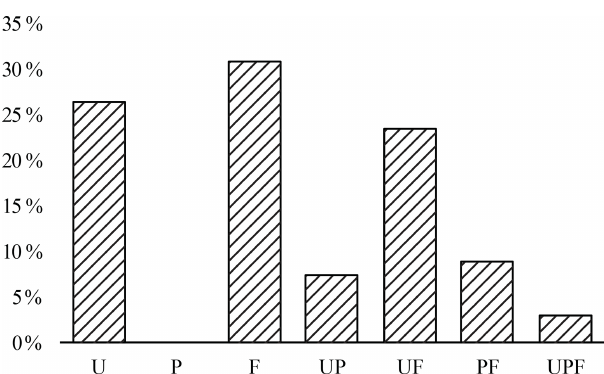
Figure 6. The frequency (as a percentage) of the device fold states when the device is transported or